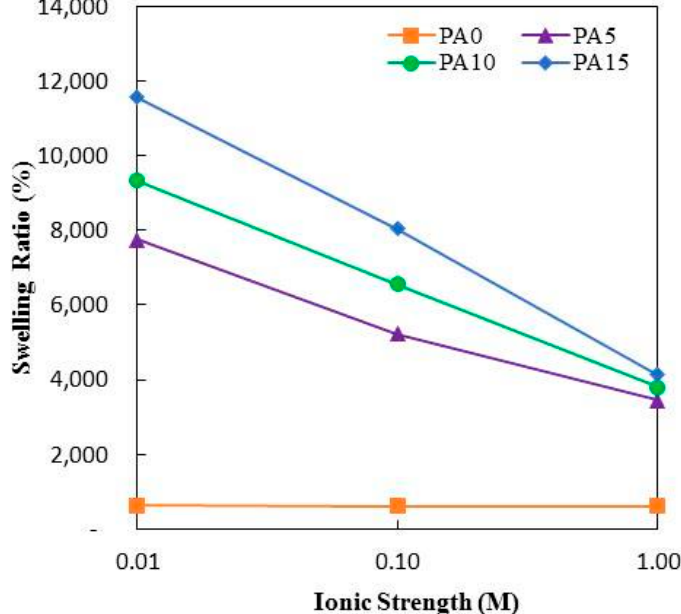
Figure 9. Effect of ionic strength on swelling ratio of PA hydrogels prepared at radiation dose 30 kGy.